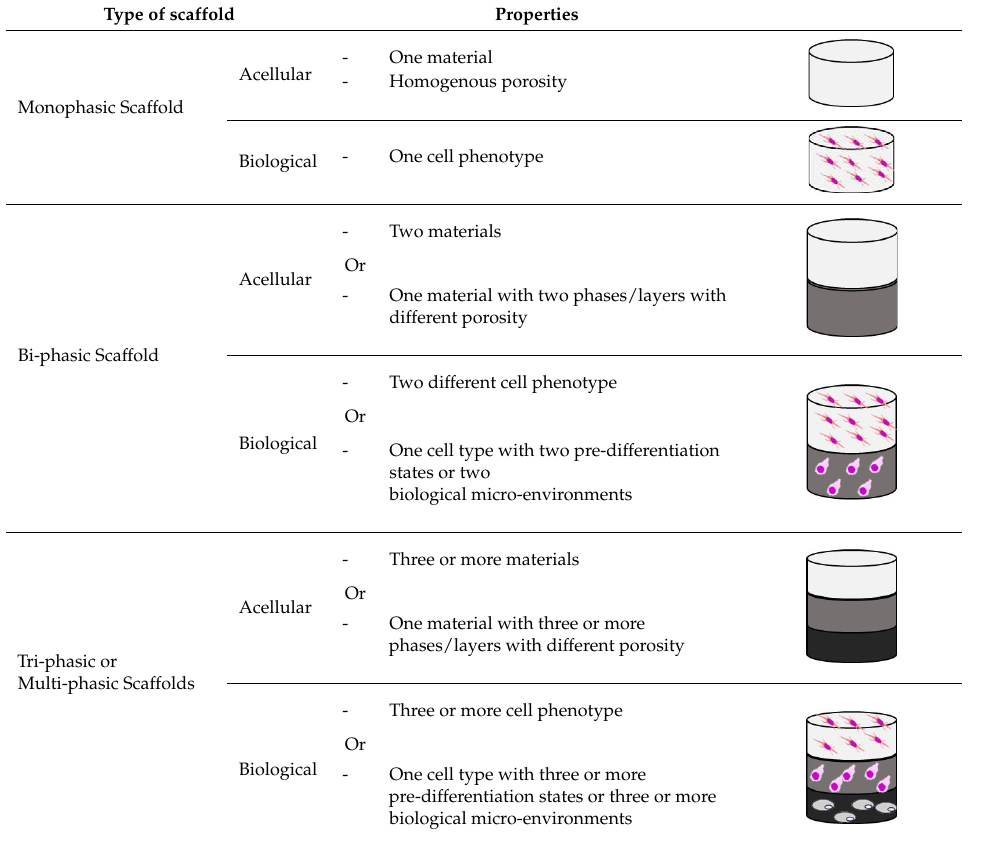
Table 1. Osteochondral phasic scaffold design strategies.